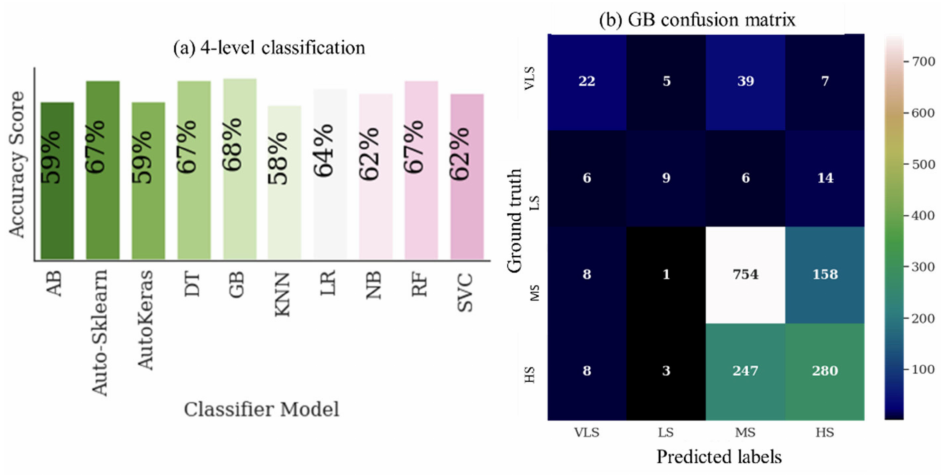
Figure 7. ( a ) Four-level accuracy performance. ( b ) Confusion matrix for GB. Similarly, the accuracy performance of the proposed customized is evaluated for a five-level severity prediction (Figure 8).